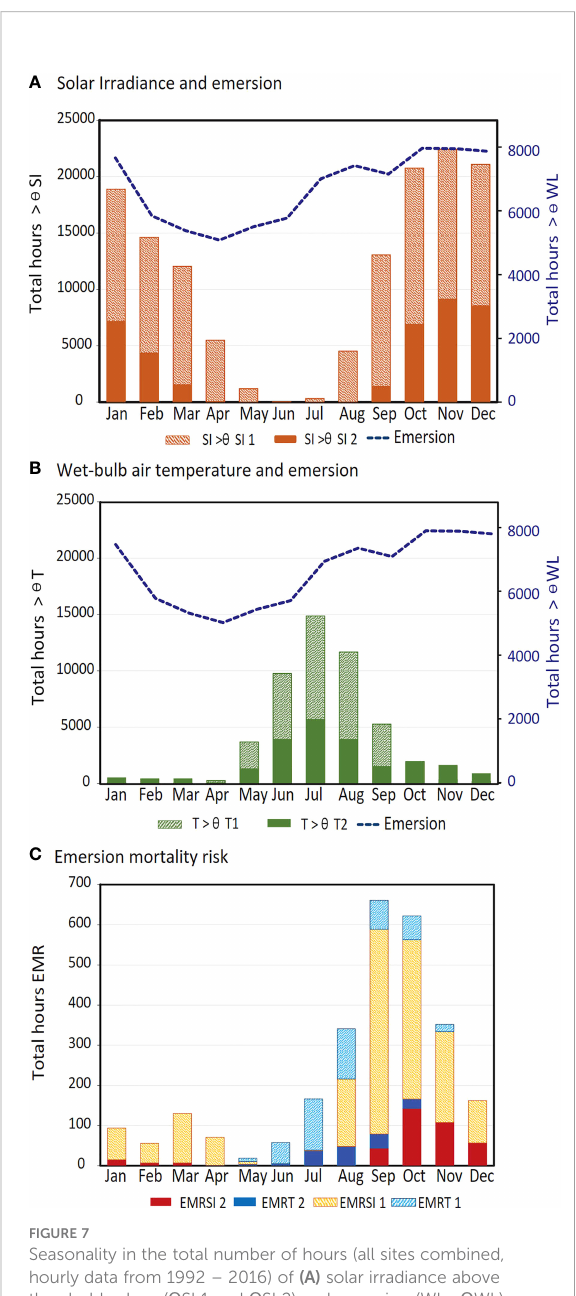
FIGURE 7 Seasonality in the total number of hours (all sites combined, hourly data from 1992 – 2016) of (A) solar irradiance above threshold values ( Ɵ SI 1 and Ɵ SI 2) and emersion (WL< Ɵ WL), (B) atmospheric temperature below threshold values ( Ɵ T w 1 and Ɵ SI 2) and emersion (WL< Ɵ WL), and (C) emersion mortality risk (EMR) due to high solar irradiance (SI) and low atmospheric temperature (T w